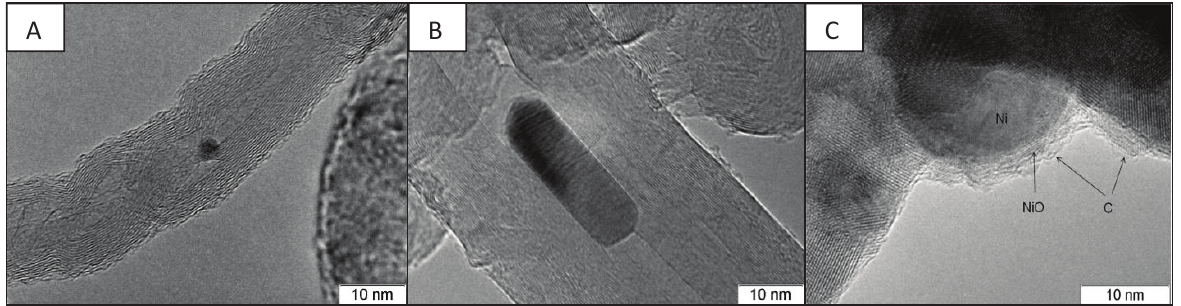
Figure 10: TEM images of Ni/Ce-Zr catalysts after MDR: A-Ni/B1, B-Ni/Ch, C-Ni/B2. Table 6: Comparison of specifi c catalytic activity of 5%Ni/Ce samples at 600°C.